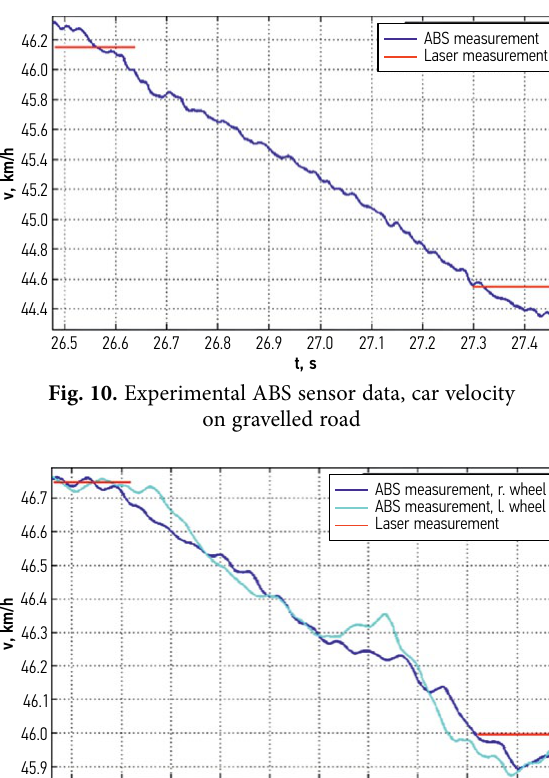
Fig. 9. Experimental ABS sensor data, car velocity